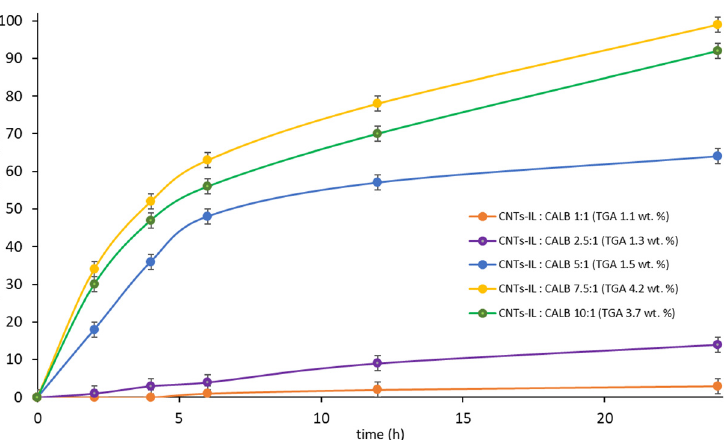
Figure 2. The influence of the mass ratio of CNTs-IL to CALB used for the preparation of CNTs-IL-CALB on the biocatalyst activity. Preparation of CNTs-IL-CALB conditions : 1st step: CNTs 1.0 g, [N(CH 3 ) 3 GlcOCH 3 ][N(Tf) 2 ] 0.5 g, acetonitrile 25 mL; 2nd step: CNTs-IL 1.0 g, 1.0–10 g CALB, water 30 mL; Reaction conditions : AA 0.072 g (1 mmol), n -BuOH 0.149 g (2 mmol), cyclohexane 1 mL, CNTs-[N(CH 3 ) 3 GlcOCH 3 ][N(Tf) 2 ]-CALB 0.150 g, 24 h, 25 °C, 250 rpm.